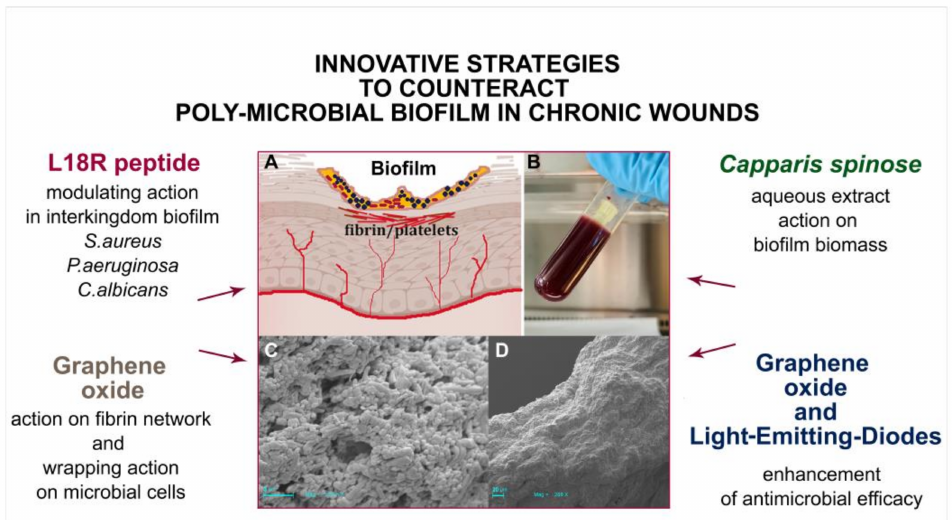
Figure 3. Recent innovative strategies to counteract biofilms in chronic wounds. ( A ) Representative schematization of biofilm in a wound bed; ( B ) the 48h mature biofilm in Lubbock chronic wound biofilm (LCWB) model; ( C , D ) Electron Scanning microscopy representative images of LCWB; (C, scale bar 3 µ m.; D, scale bar 20 µ